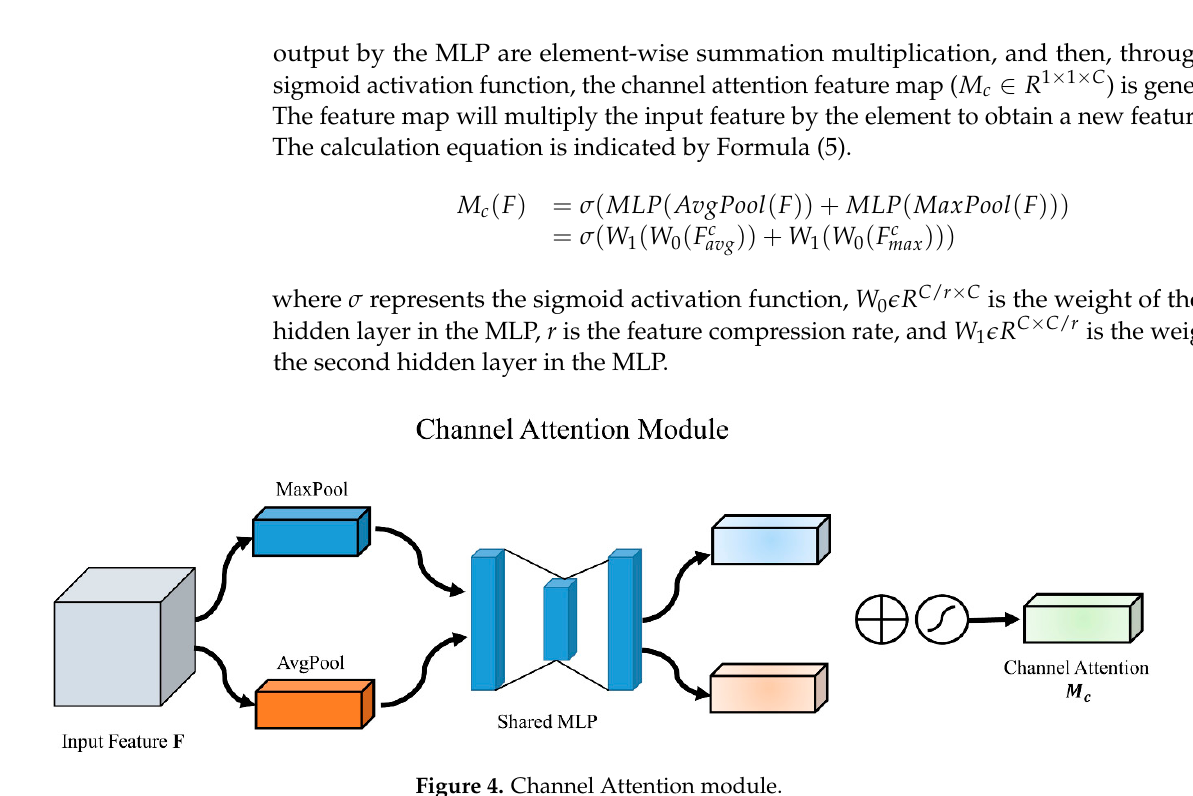
Figure 4. Channel Attention module.